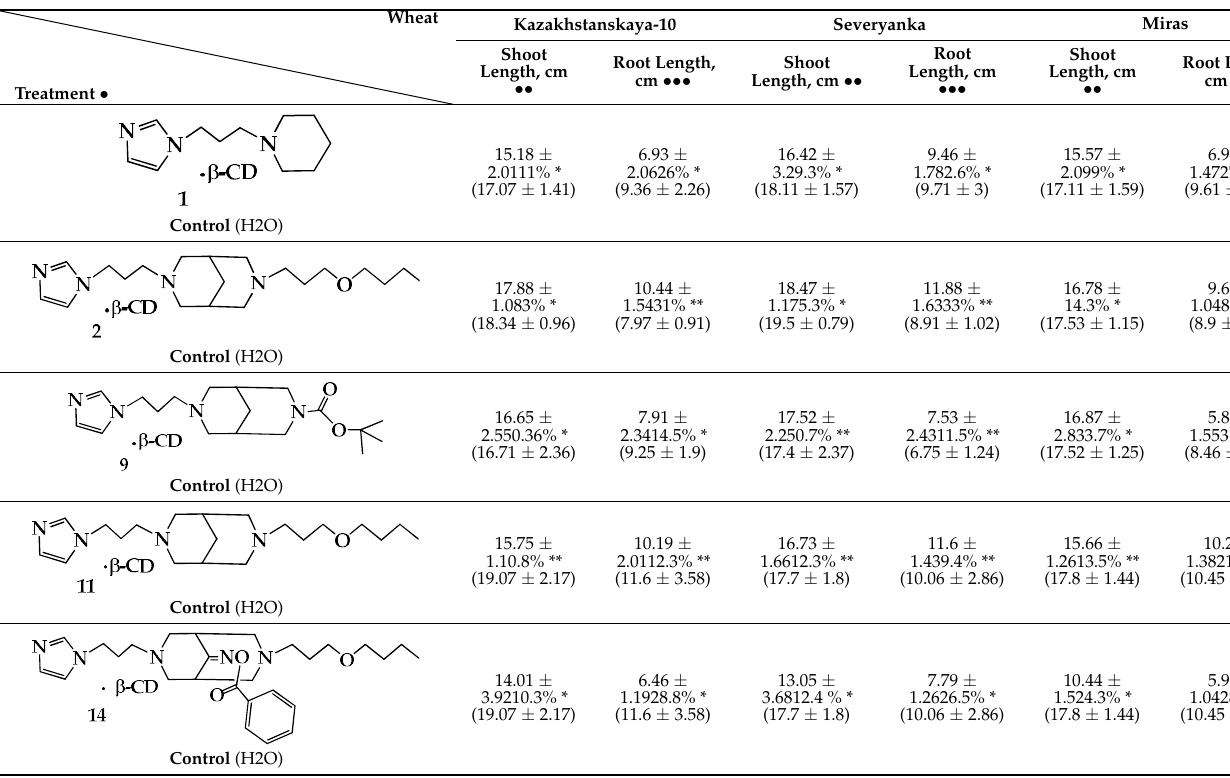
Table 1. Biometric data for three varieties of wheat when seedlings of each wheat were treated with β-CD complexes of substituted bicyclo[3.3.1]nonanes 1 , 2 , 9 , 11 , and 14 in comparison with untreated systems in water ( n = 15). (15 replicates).